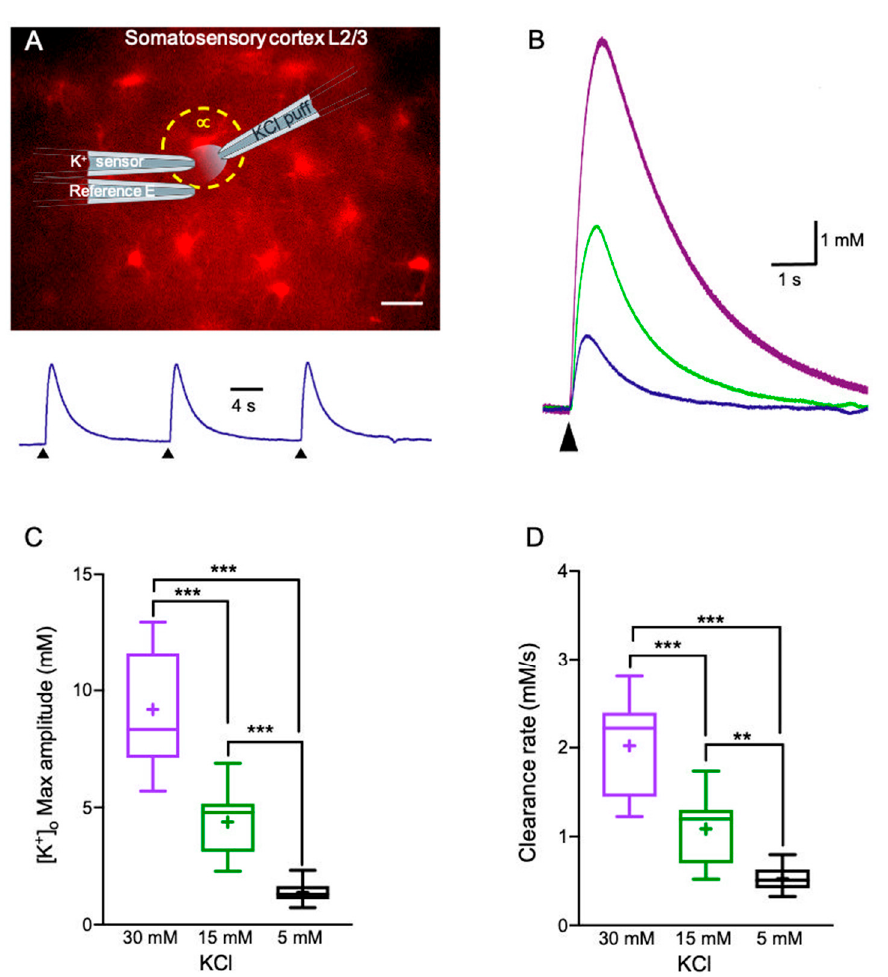
Figure 1. Measuring K + clearance in acute brain slices. ( A ) Top—Fluorescence image of a brain slice depicting astrocytes stained with SR101 along with schematic diagram of the K + recording electrode and the KCl puffing pipette (scale bar—20 µ m). Bottom—sample traces of [K + ] o recordings following repetitive stimulation with 5 mM KCl, arrows indicate the time of KCl application; yellow circle surrounds an astrocyte nearby the recording electrode (astrocyte ∝ ). ( B ) Average traces of 3 repetitive [K + ] o recordings depicting the K + clearance time course following local application of 30 mM (purple), 15 mM (green), and 5 mM (blue) KCl puffs. ( C , D ) Box plots depicting the maximal amplitude ( C ) and clearance rate ( D ) following local application of 5, 15, and 30 mM KCl. The box upper and lower limits are the 25th and 75th quartiles, respectively. The whiskers depicting the lowest and highest data points, while the + sign represents the mean and the horizontal line through the box is the median. ** p < 0.01; *** p < 0.001; one-way ANOVA.